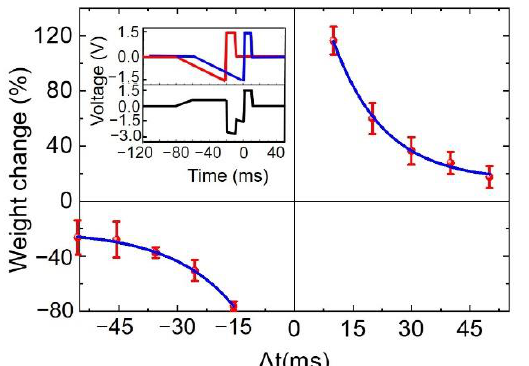
Figure 10. Implementation of the STDP learning rule for the NP-embedded devices. The synaptic weight change ( ∆ w ) was tested as a function of the temporal difference ( ∆ t ) between the pre-spike (blue) and post-spike (red) that are schematically shown in the inset. Equivalent stimulus in black applied to the device is schematically shown in the inset with ∆ t = 20 ms. ∆ w is defined as ( w 2 − w 1 )/ w 1 , where w 1 and w 2 , respectively, represent synaptic weights before and after stimulus.